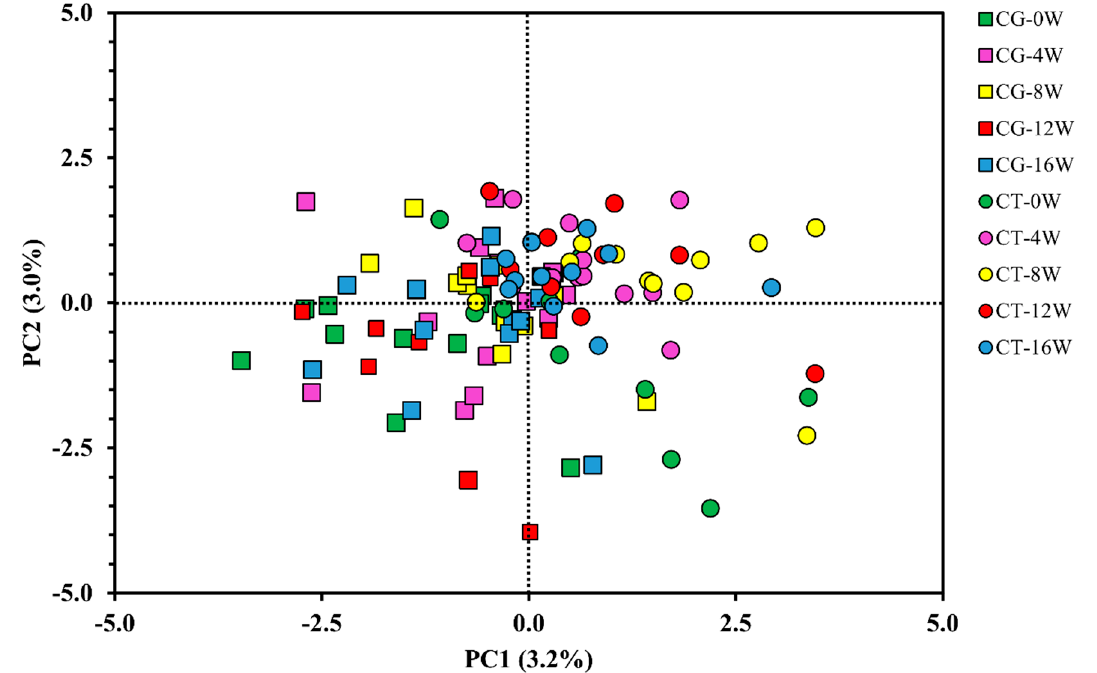
). Colours vary (cid:35)